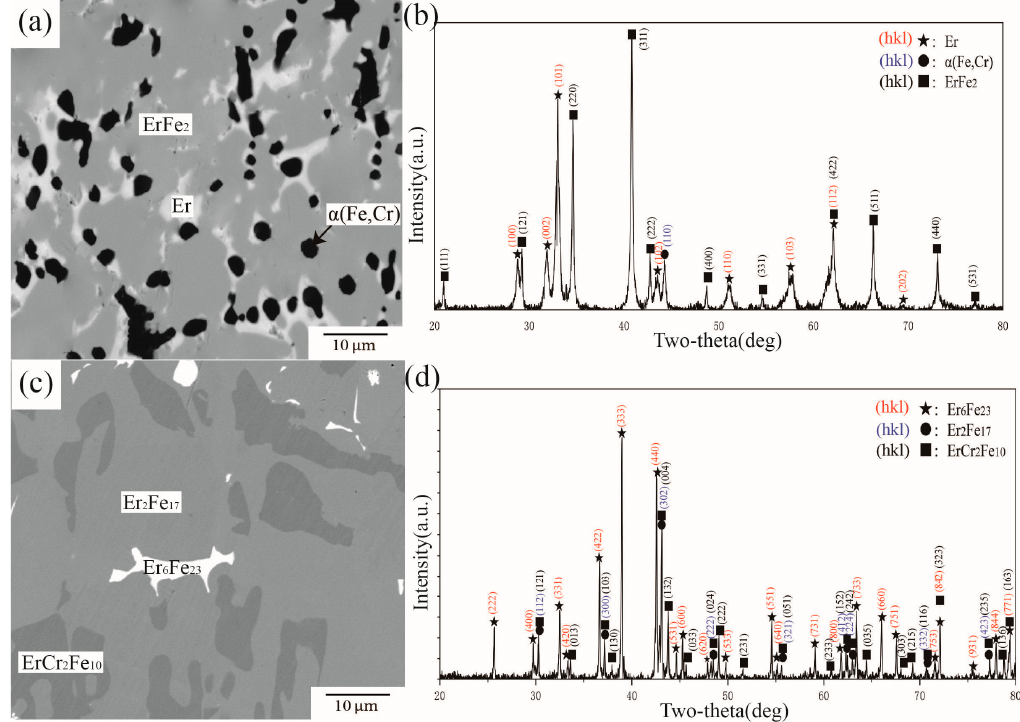
Figure 14. ( a ) BSE image of alloy C4, ( b ) XRD result of alloy C4, ( c ) BSE image of alloy C8, ( d ) XRD result of alloy C8.